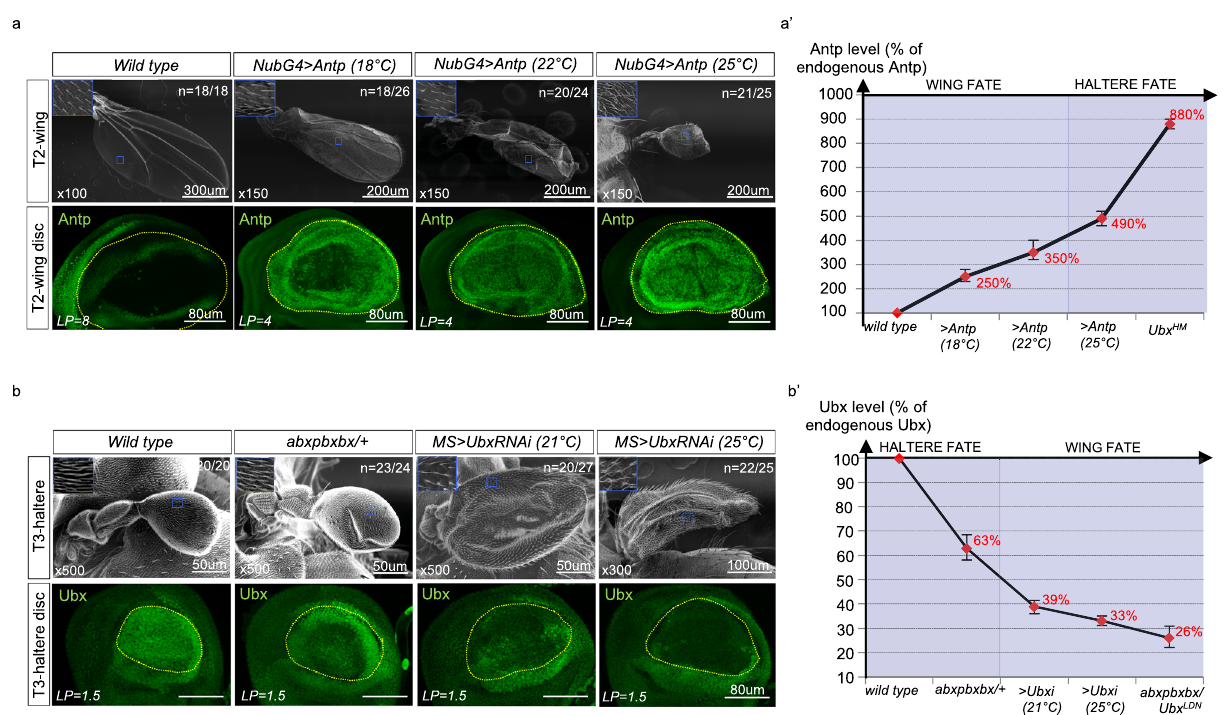
Fig. 7 Different Hox doses are instructive for fl ight appendage morphology in Drosophila . a Increasing the dose of Antp in the wing disc pouch led to progressive wing-to-haltere transformation phenotypes. Overexpression of Antp was performed with the Nub-Gal4 driver at different temperatures. This driver starts to be expressed at late second instar larval stage 44 . Effects were observed in two independent experiments and fl uctuate from 69% (18 °C, n = 18/26) to 83% (22 °C, n = 20/24) and 84% (25 °C, n = 21/25) of the total number of dissected wings. Enlargements on SEM pictures show hairs ’ shape and organization, which look like in the haltere at the highest Antp dose. Bottom panels show the immunostaining of Antp in each condition (green, a minimum n = 10 from two independent experiments). b Decreasing the dose of Ubx in the haltere disc pouch led to progressive haltere-to-wing transformations. Ubx expression was affected by using the abxpbxbx heterozygous allele, and by expressing RNAi against Ubx with the MS1096-Gal4 driver at two different temperatures. These effects were robustly observed in two independent experiments and fl uctuate from 96% ( abxpbxbx/ + , n = 23/24) to 74% (21 °C, n = 20/27) and 88% (25 °C, n = 22/25) of the total number of dissected halteres. Enlargements on SEM pictures show hairs ’ shape and organization, which look like in the wing at the lowest Ubx doses. Bottom panels show the immunostaining against Ubx in each condition (green, a minimum n = 10 from two independent experiments). a ′ , b ′ Curves showing the relationship between the wing or haltere fate and the level of Antp or Ubx (given as a percentage of the corresponding endogenous expression level in the wild-type condition, and deduced from the mean quanti fi cation relative to the laser power (LP) for fl uorescent immunostaining in the pouch). Wing and haltere fates were deduced from SEM acquisitions, taking into account the size, the presence or not of veins, and the organization of hairs. Bars represent mean ± SD of two independent